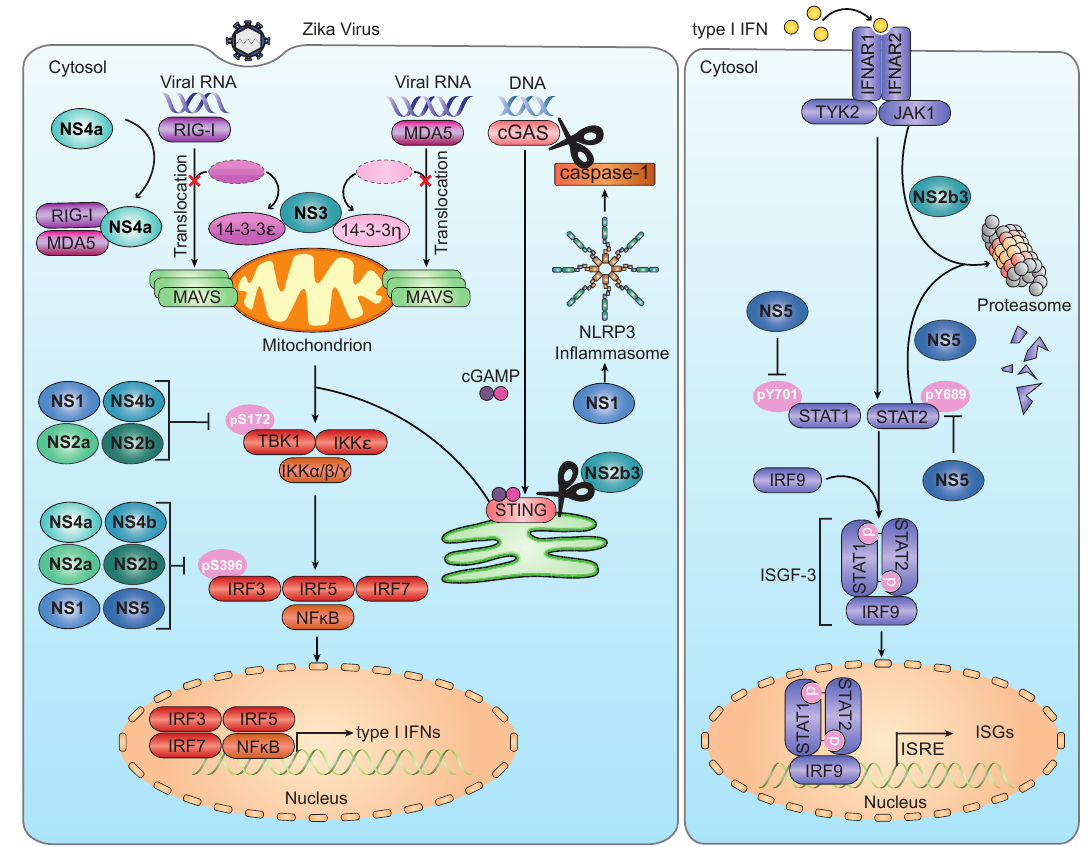
Figure 1. Zika-virus-mediated inhibition of the signaling pathways that lead to type I interferon (IFN) and IFN-stimulated genes (ISG) induction. During Zika virus (ZIKV) infection, a multitude of viral nonstructural (NS) proteins are involved in antagonism of signal transduction mediated by pattern-recognition-receptors (PRRs) leading to type I interferon (IFN) induction (left panel), as well as of IFN-mediated expression of IFN-stimulated genes (ISGs) (right panel). ZIKV NS3 interacts